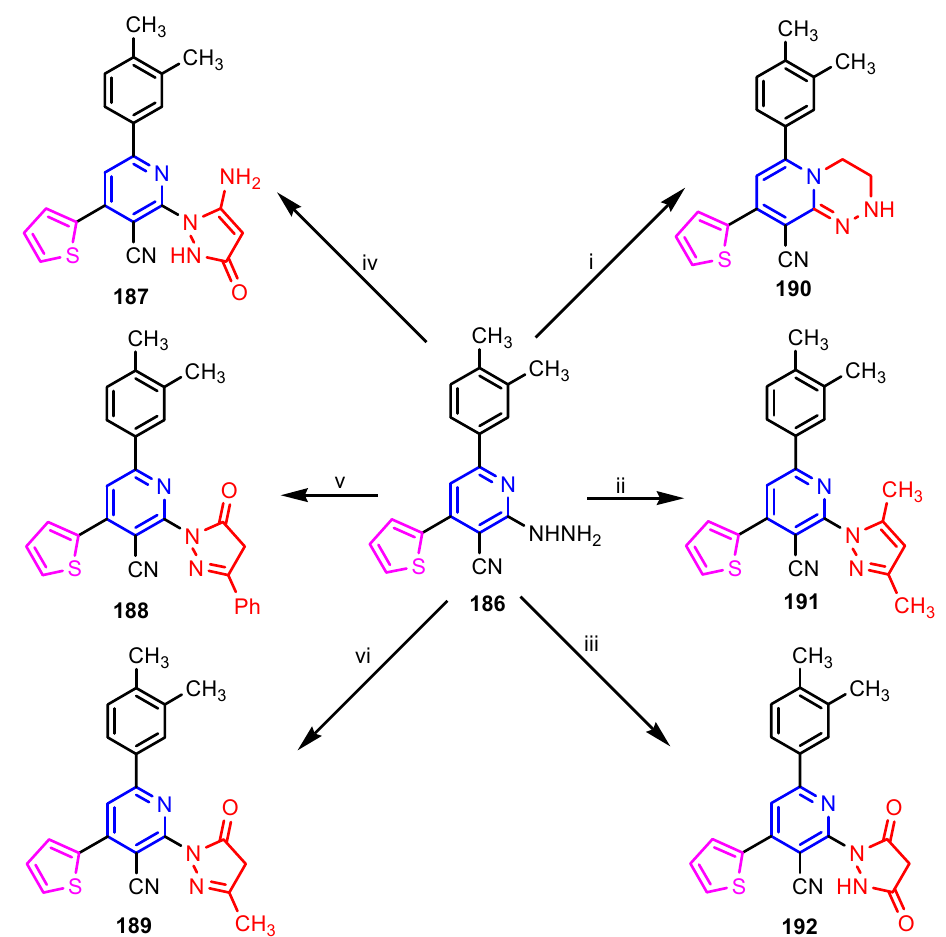
Scheme 41. Synthesis of compounds 187 – 192 ; reagent and conditions: (i) ClCH 2 CH 2 Cl, DMF, heat; Scheme 40. Synthesis of pyridoquinolone 183a − 183b [77].